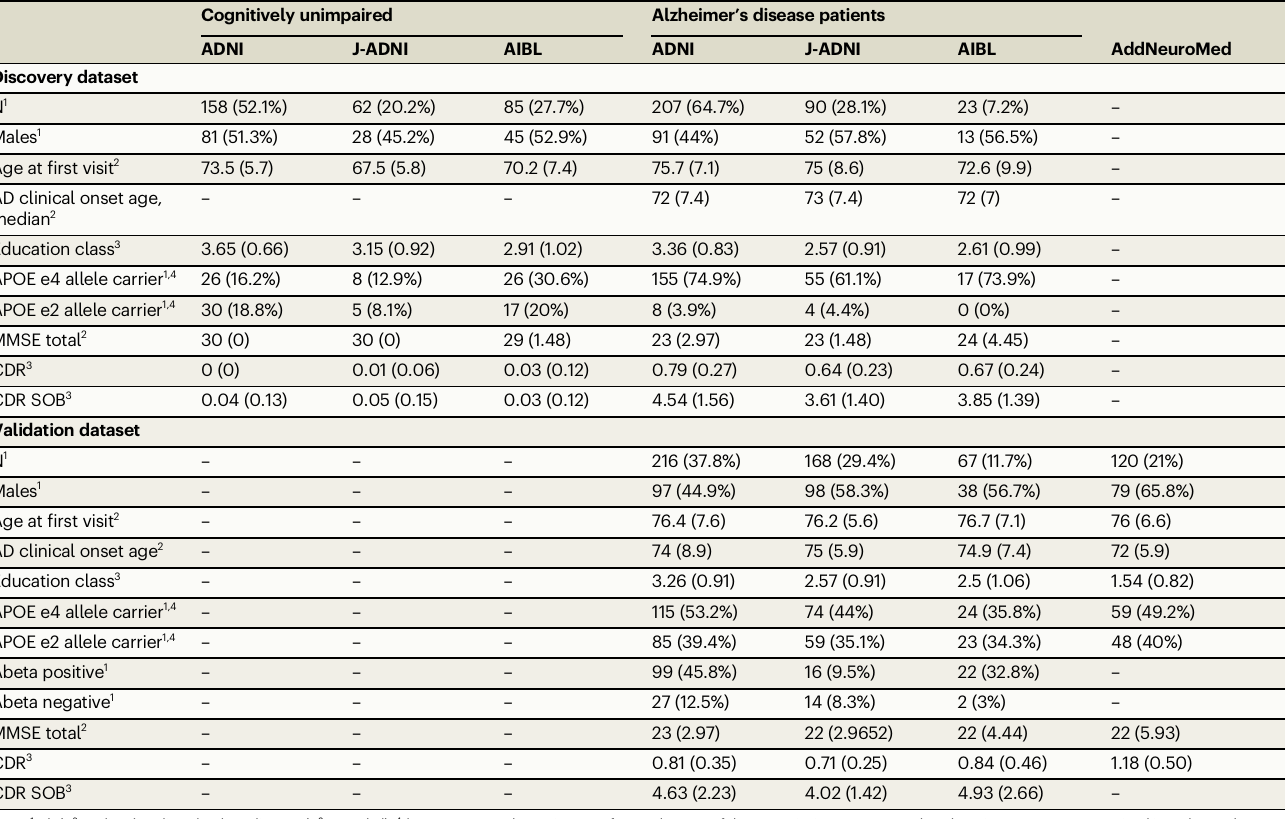
Table 1 | Demographic and clinical characteristics of participants in the cohorts included in the training and validation